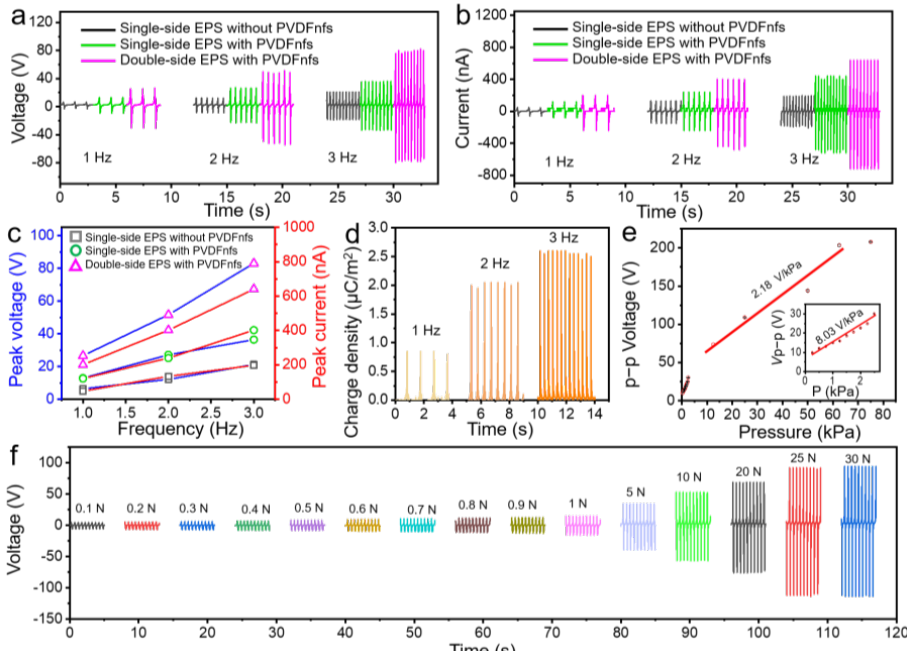
Figure 3. The response voltage of the three as-prepared sensors from the single-side EPS without PVDFnfs, the single-side EPS with PVDFnfs, and the double-side EPS with PVDFnfs is shown in ( a ) output voltage, ( b ) short-circuit current, and ( c ) comparison of the corresponding peak voltage and peak current versus different frequency. The double-side EPS with PVDFnfs sensors of ( d ) charge density at different frequencies, ( e ) the peak to peak response voltage under various pressure from 0.25 kPa to 75 kPa at 2 Hz, and ( f ) their voltage response to the corresponding forces from 0.1 N to 30 N.